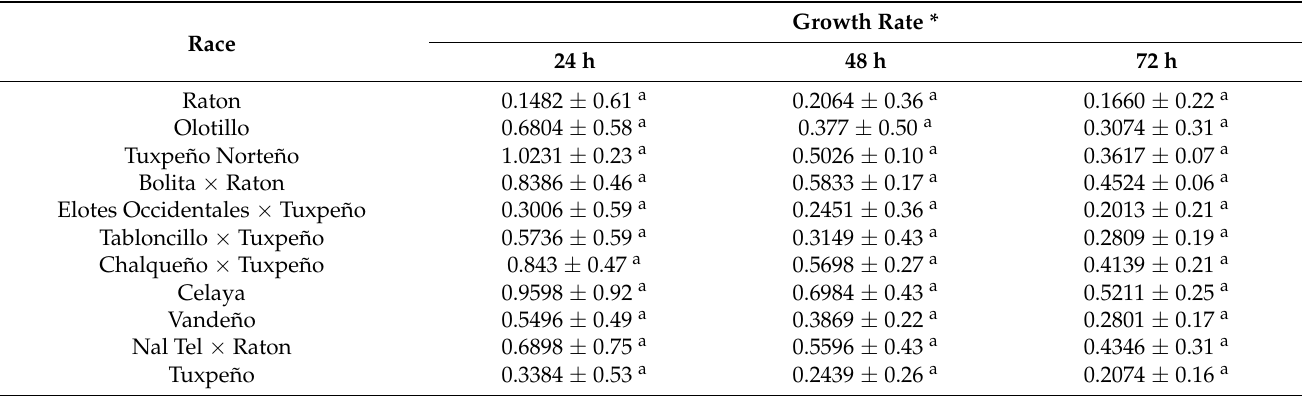
* Means values and ± standard deviation (SD) is presented. Same letters indicate are not significantly different ( p < 0.05; MANOVA and LSD’s test).